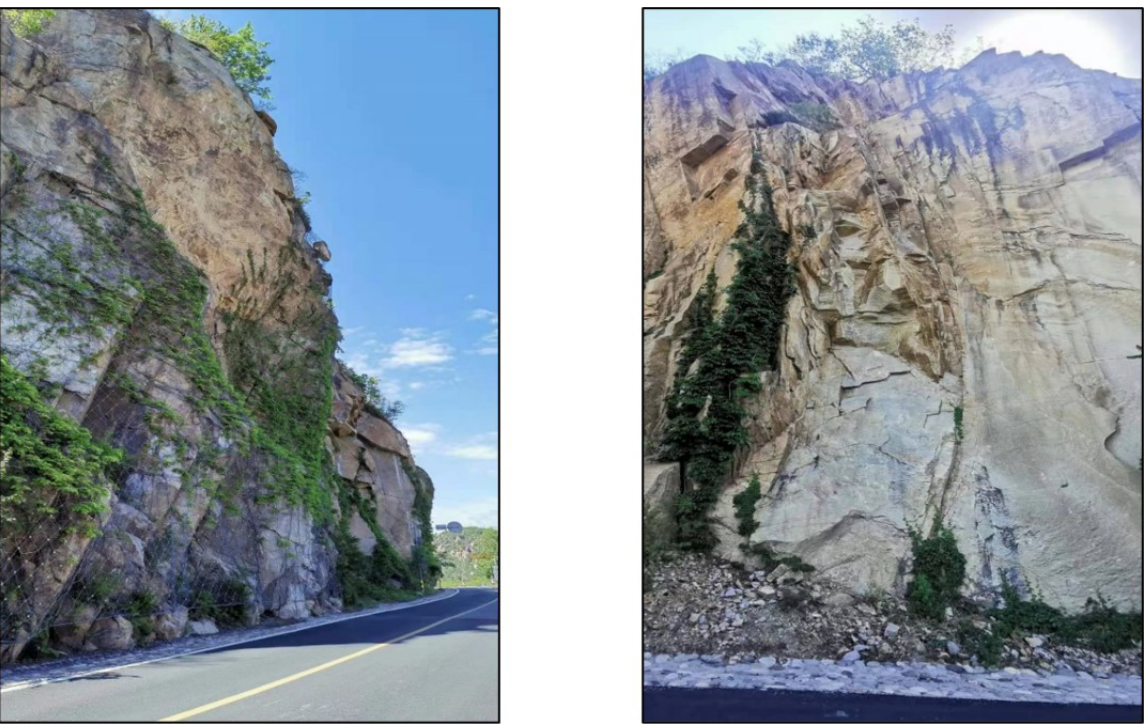
Figure 1. High and steep slopes.